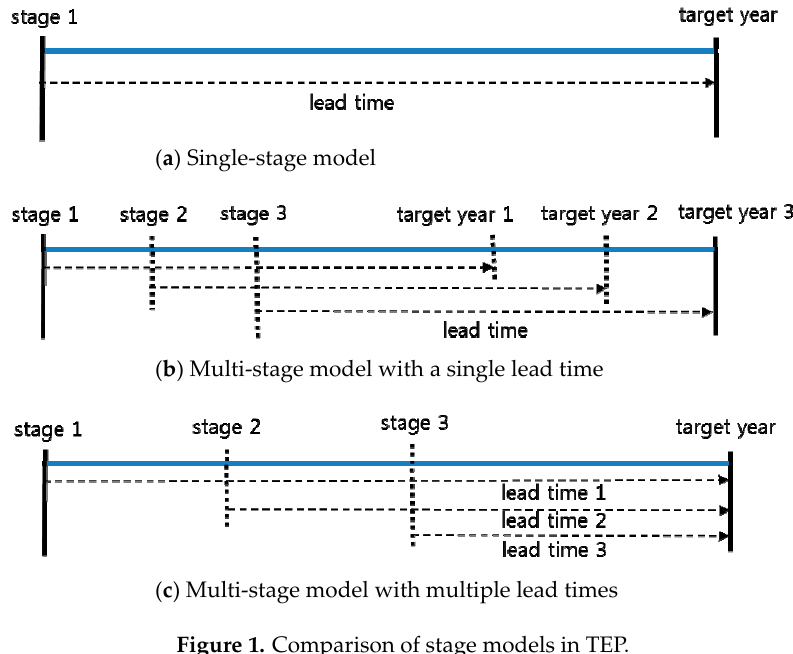
Figure 1. Comparison of stage models in TEP.